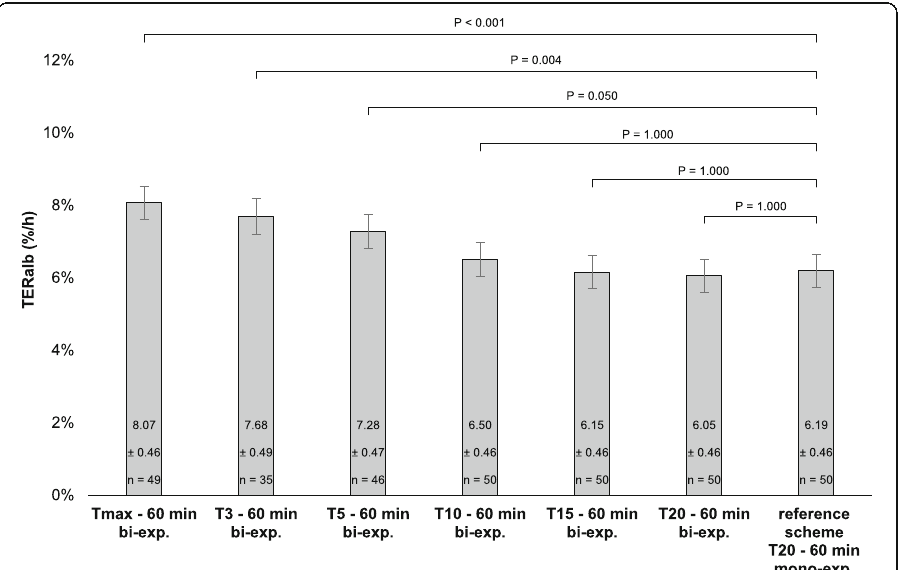
Fig. 4 TER alb for the different blood sampling schemes based on a bi-exponential kinetic model, compared with the